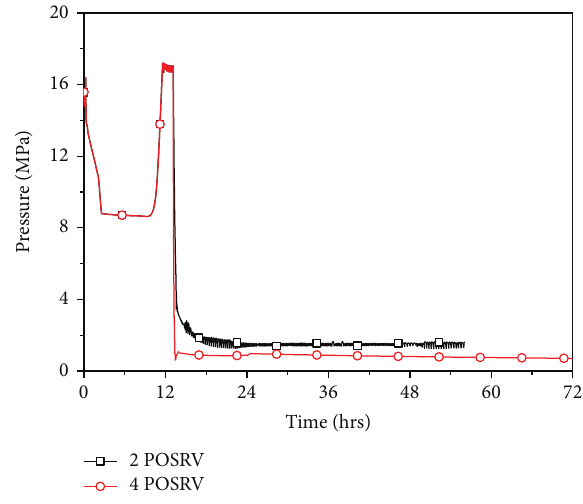
Figure 12: Primary injection RCS pressure.